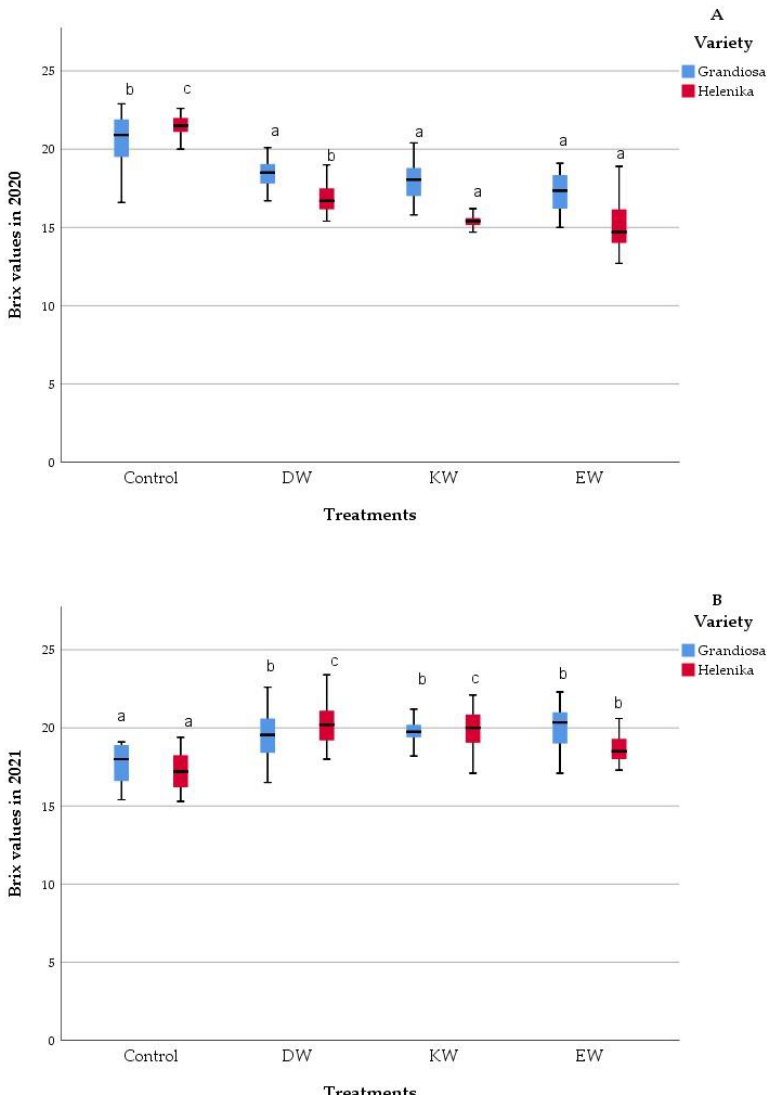
Figure 4. Sugar concentration (°Brix value) of sugar beet cultivars in 2020 ( A ) and 2021 ( B ). Values with same letters indicate no significant difference between the treatments. N = 32. In 2021, in case of ‘Helenika’ Tukey’s Post Hoc Test, ANOVA, p < 0.05, was used. In all other cases, non-parametric Kruskal-Wallis Test, p < 0.05, was used.